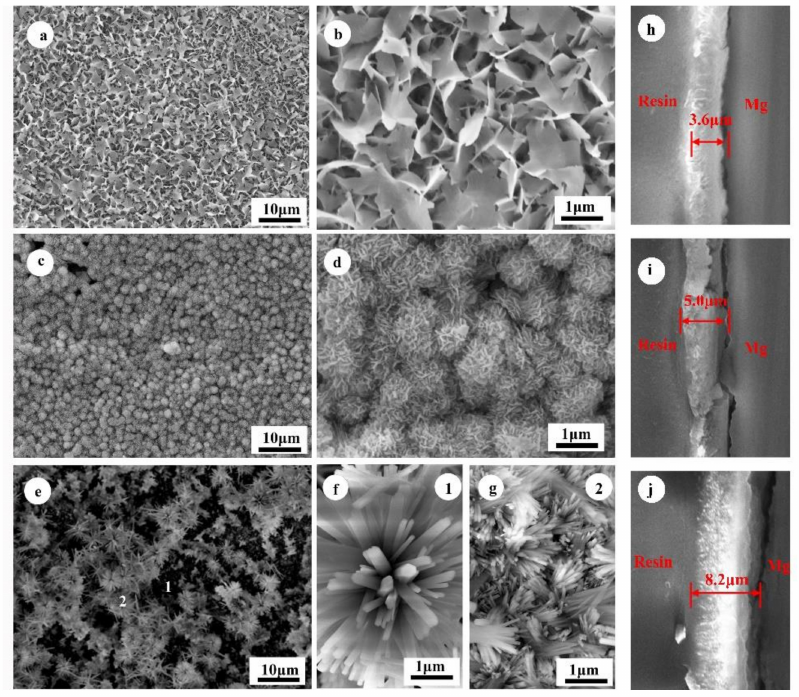
Figure 3. Scanning electron microscopy (SEM) images showing morphologies of HA5 ( a , b ), HA7 ( c , d ), and HA9 ( e , f , g ); cross-section images of the HA coatings, HA5 ( h ), HA7 ( i ), and HA9 ( j